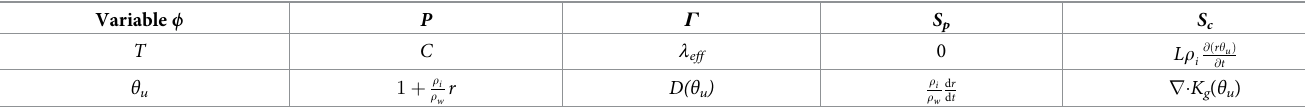
Table 1. Specific parameters of generalized variables used in numerical simulation.